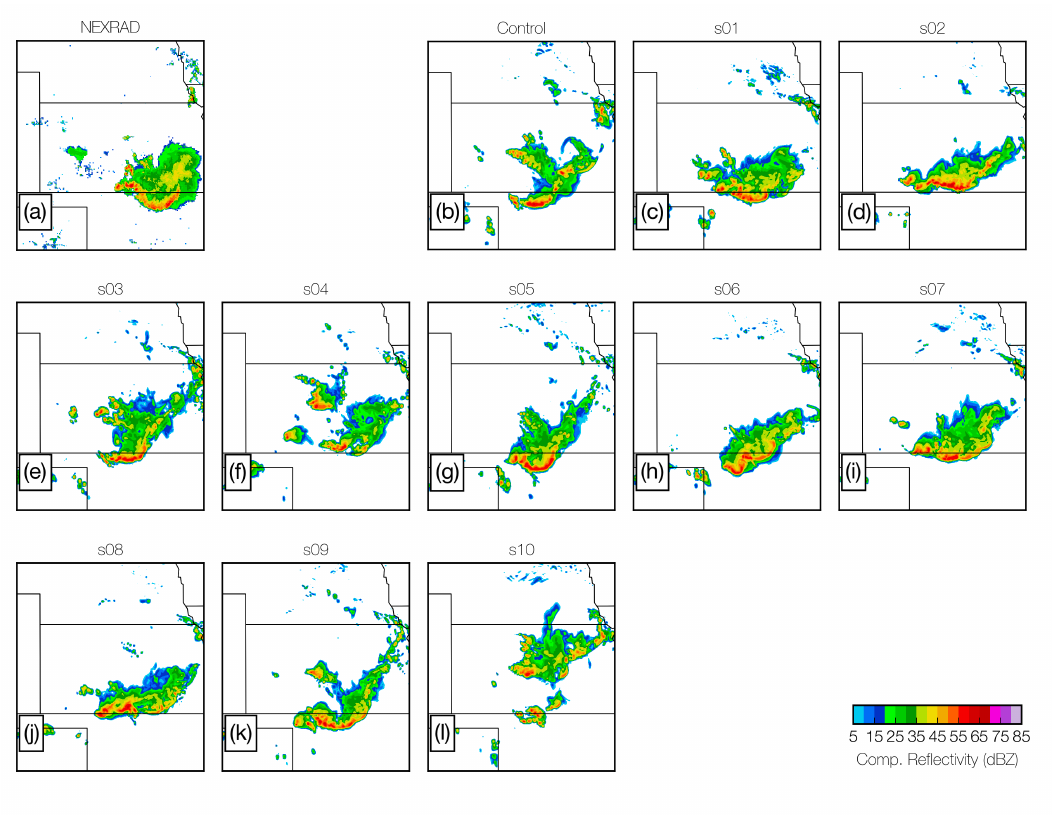
Figure 4. Thumbnails of observed ( a ) and simulated ( b – l ) composite reflectivity, valid at 0300UTC 16 August 2013 (27h simulation time), for the single-nest EPS. Reflectivity is contour-filled in dBZ according to the